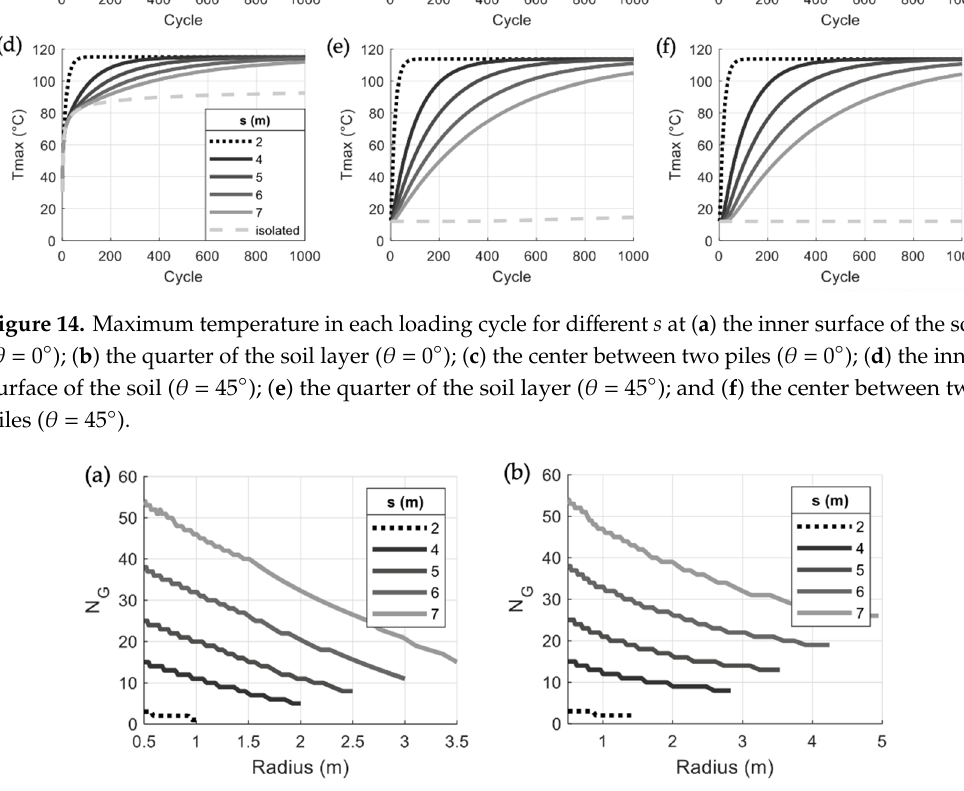
Figure 14. Maximum temperature in each loading cycle for different s at ( a ) the inner surface of the soil ( θ = 0°); ( b ) the quarter of the soil layer ( θ = 0°); ( c ) the center between two piles ( θ = 0°); ( d ) the inner surface of the soil ( θ = 45°); ( e ) the quarter of the soil layer ( θ = 45°); and ( f ) the center between two piles ( θ = 45°).